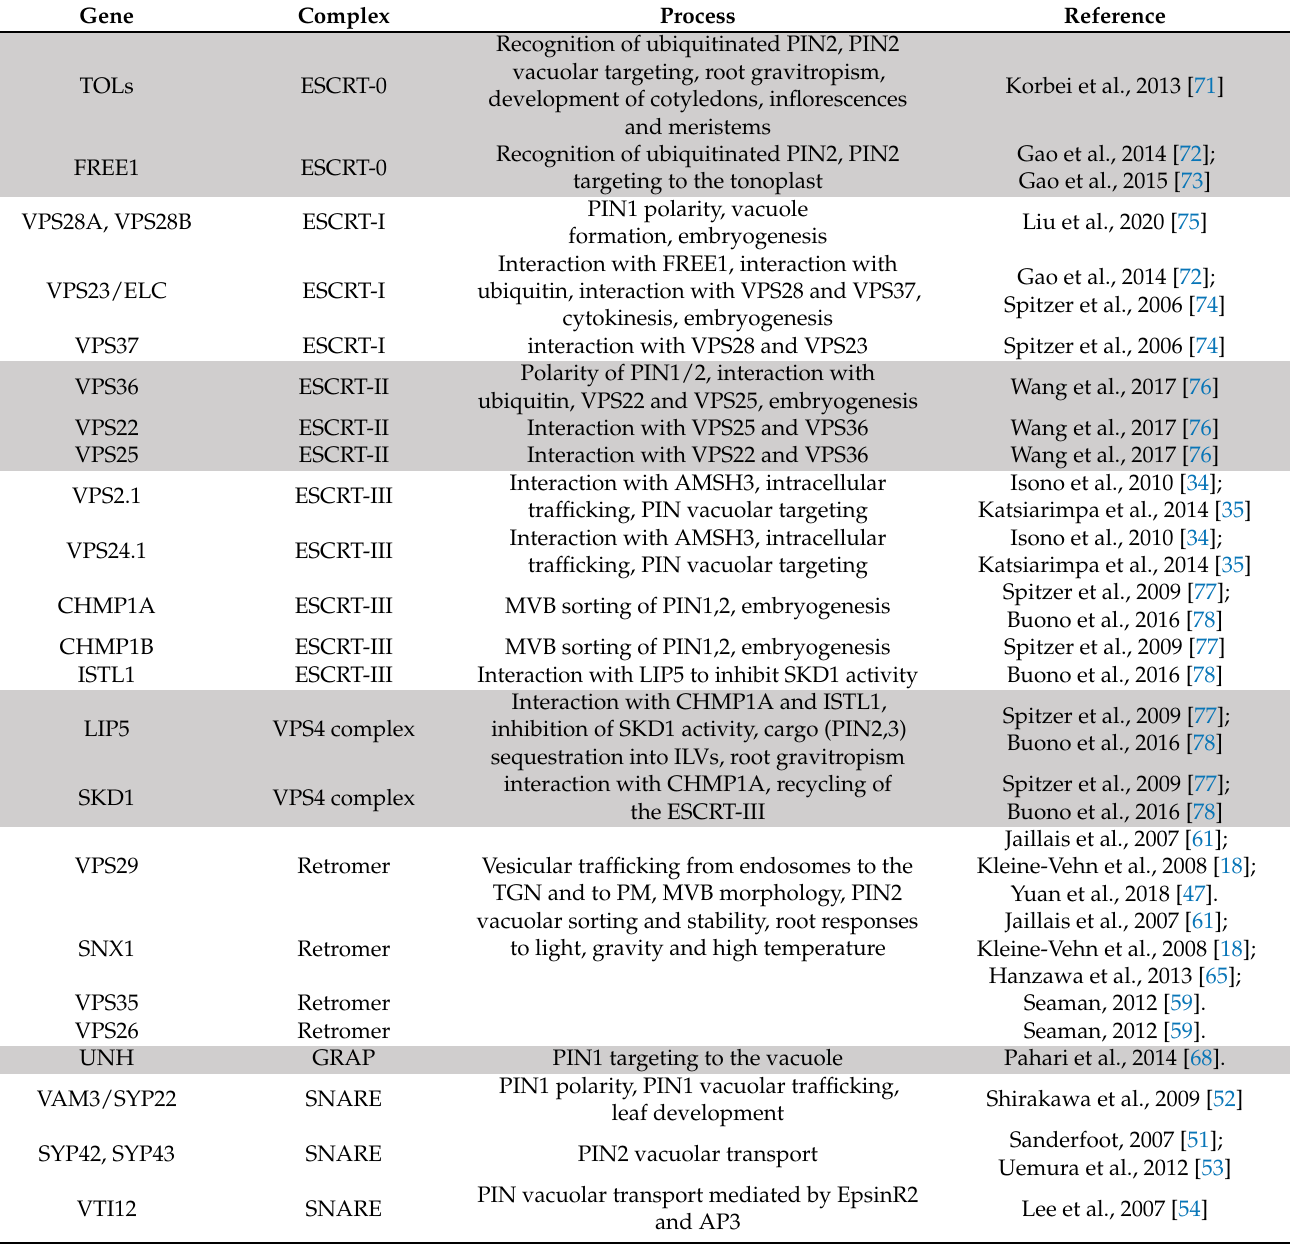
Table 1. Intracellular components involved in PIN vacuolar